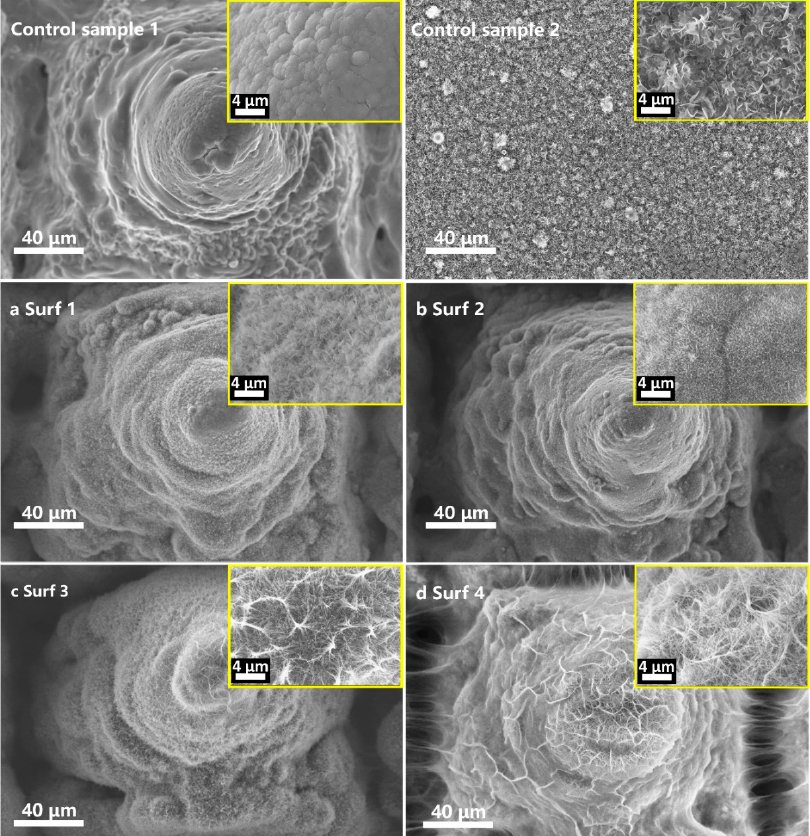
Figure 4. Control sample 1 is the sample only treated by laser processing. Control sample 2 is the sample only treated by hydrothermal treatment, where the hydrothermal temperature was 190 °C.